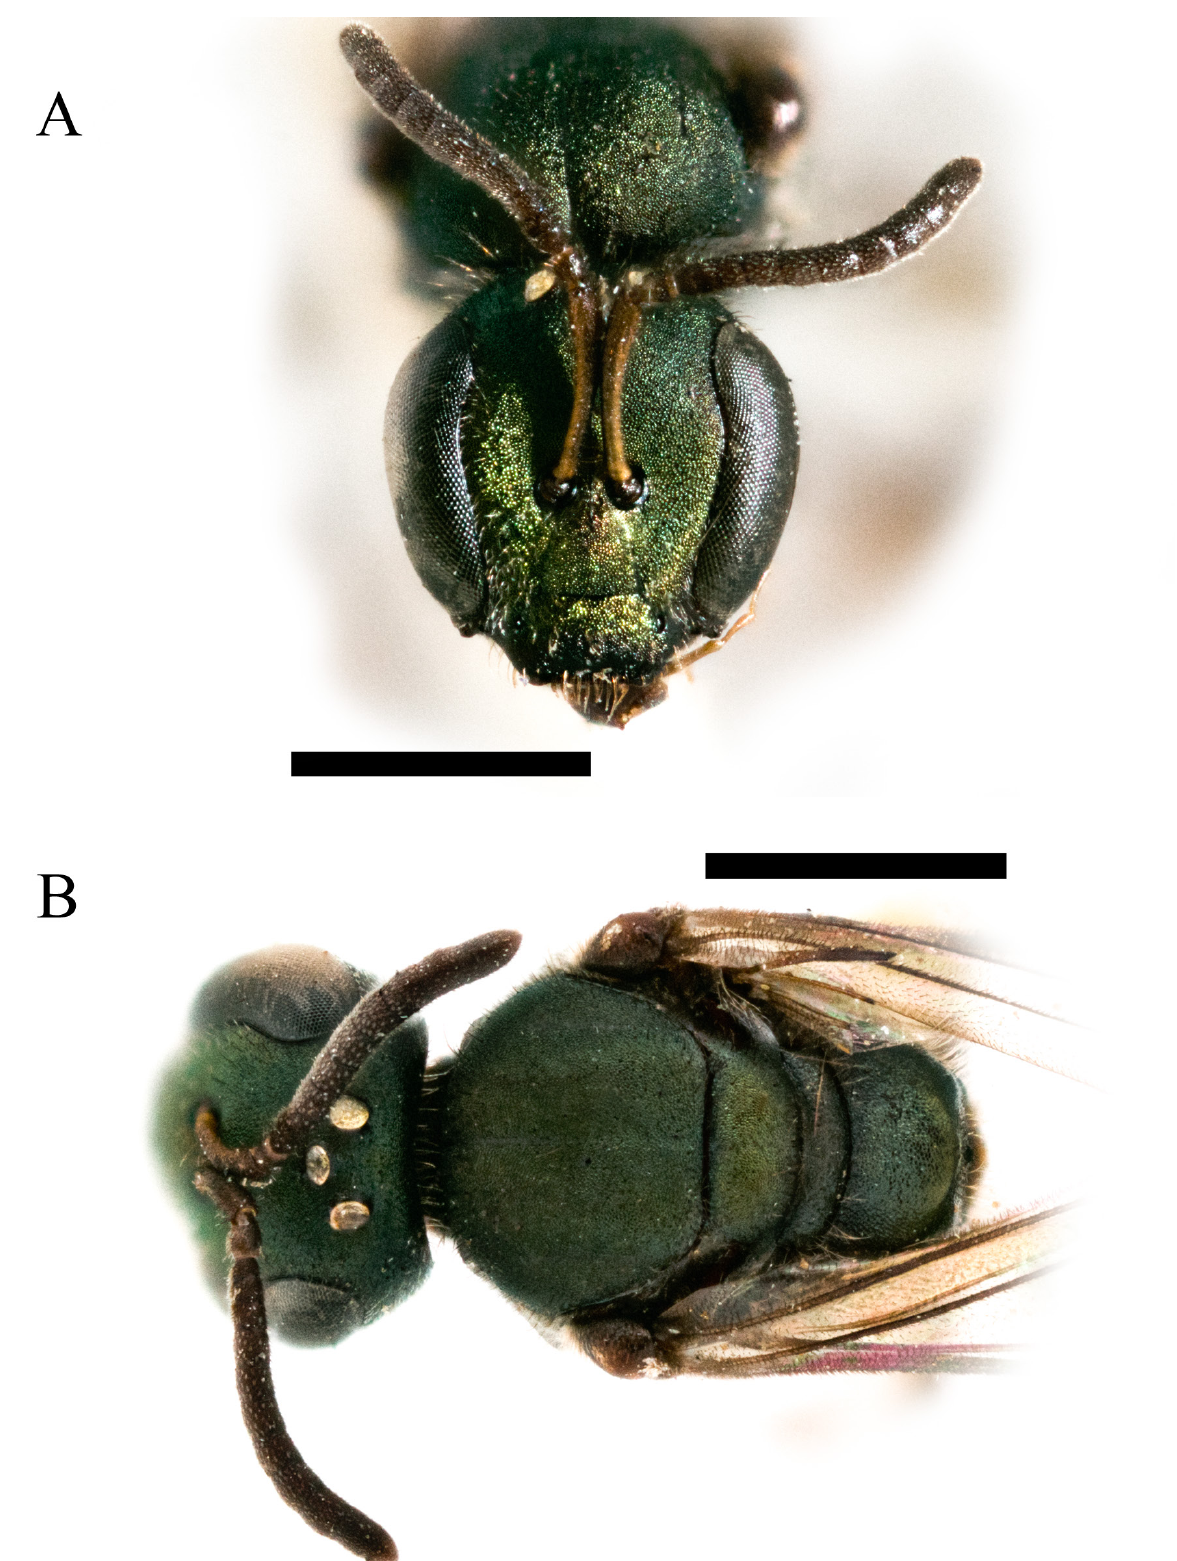
Fig. 7. Lasioglossum ( Habralictellus ) punctifrons (Crawford, 1914). Holotype, ♀. A . Face. B . Dorsum of mesosoma. Scale bars = 1